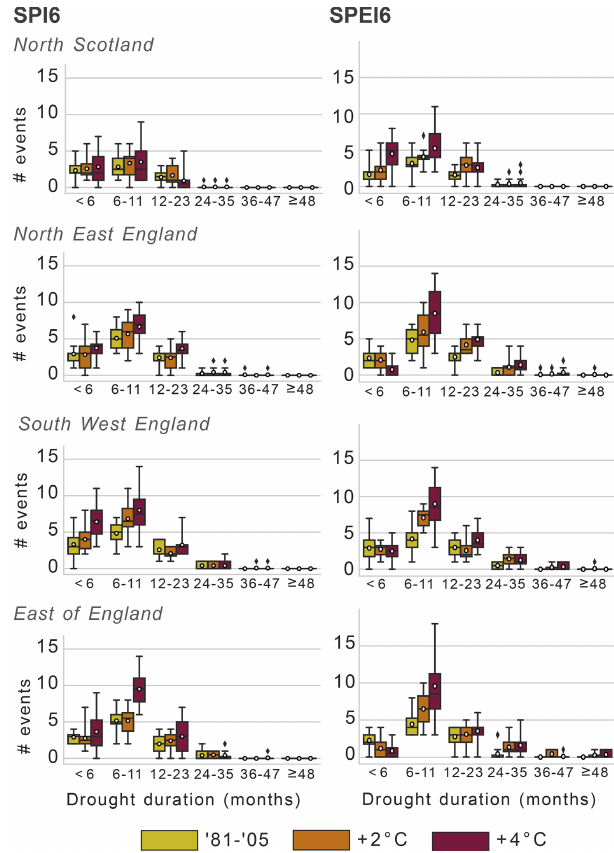
Figure 9. Number of drought events of all severities by duration for three 25-year periods corresponding to progressive warming scenarios in the selected regions (based on the SPI6). White cir- cles indicate the ensemble mean, boxes show the interquartile range and whiskers show the ensemble range except for members exceed- ing 5 × the interquartile range (diamonds). The reader is referred to Fig. S6 for the other